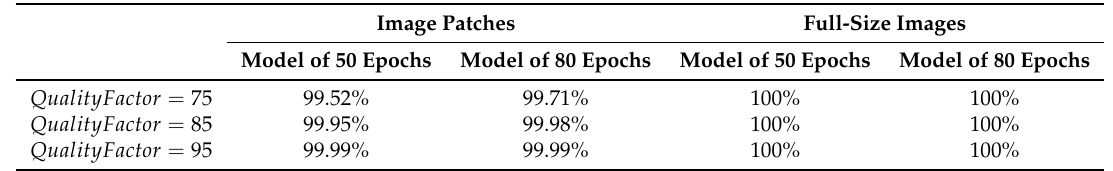
Table 2. Classification accuracy for different quality factors of natural images